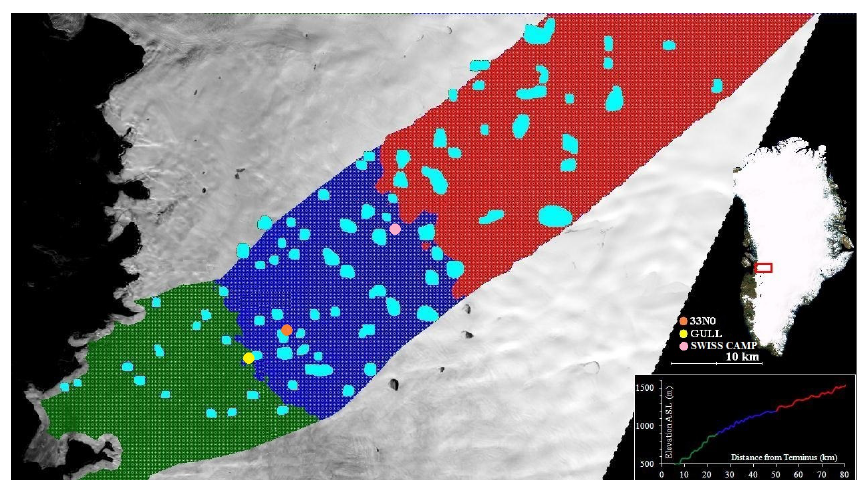
Figure 1. Study area in West Greenland, bounded by 69°48’N, 69°18’N, 50°23’W, and 2 Fig. 1. Study area in West Greenland, bounded by 69 ◦ 48 0 N, 69 ◦ 18 0 N, 50 ◦ 23 0 W, and 48 ◦ 0 0 W. A 10km swath on either side of the center flow band is shown in green, blue, and red, corresponding to <900m, 900–1200m, and >1200m elevations – elevation profile from GIMP 48°0’W. 10 km swath on either side of the center flow band shown in green, blue, and 3 30m digital elevation model (Howat et al., 2012) inset (bottom right). Chosen lake basins are shown in aquamarine (see Methods, Sect. 2.4). GPS stations at 33N0 and GULL (see Fig. 6) are shown in orange and yellow, respectively. Air temperature data (3.3) were collected at Swiss red, corresponding to <900 m, 900-1200 m, and >1200 m elevations—elevation profile 4 Camp (pink). Background: ETM + scene from August, 2002; map inset: MODIS true color from GIMP 30 m DEM (Howat et al., in prep) inset, bottom-right. Chosen lake basins 5 shown in aquamarine (see Methods, 2.4). GPS stations at 33N0 and GULL (see Figure 6) 6 shown in orange and yellow, respectively. Air temperature data (3.3) collected at Swiss 7 Camp (pink). Background: ETM+ scene from August, 2002; Map Inset: MODIS true 8 color composite. 9 10